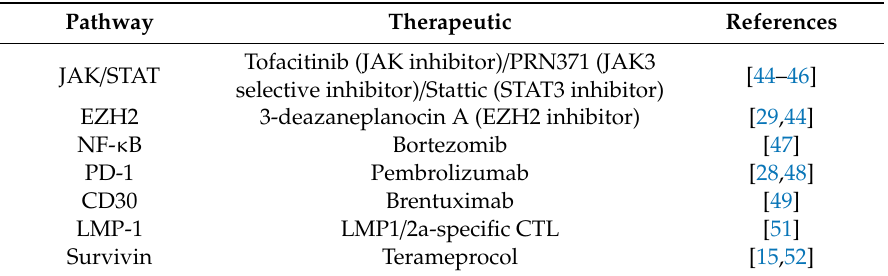
Table 1. Emerging Therapeutic Possibilities in Extranodal NK / T-cell